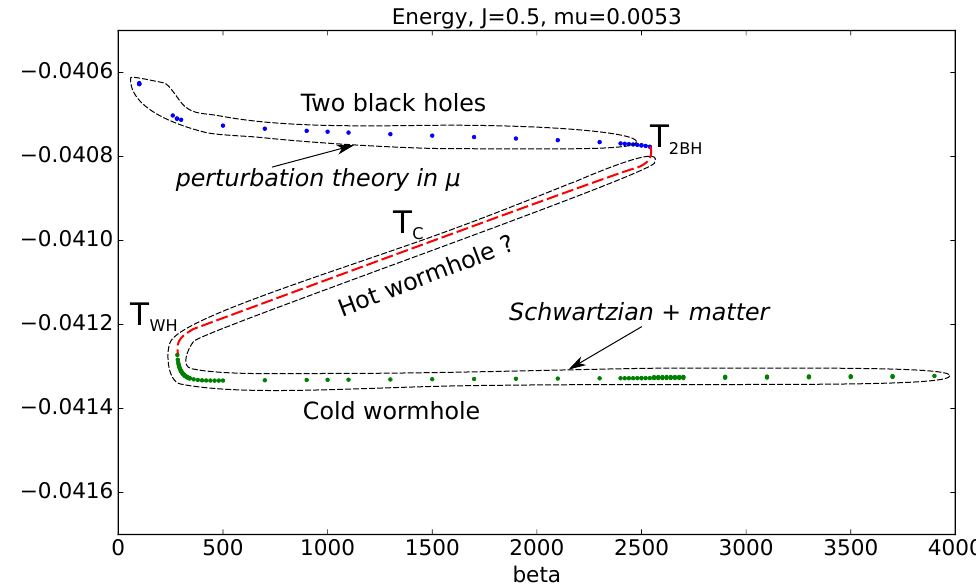
Figure 1 . Dots: energy vs beta obtained by numerically solving SD equations for two coupled SYK models with J = 0 . 5 , µ = 0 . 0053 . Blue dots correspond to the “two black holes phase”, whereas green dots correspond to the “cold wormhole phase”. Red dashed line: curve for the “hot wormhole” phase expected from a low energy analytic analysis. The question mark “?” reminds us that we were not able to find it as a solution of the Euclidean SD